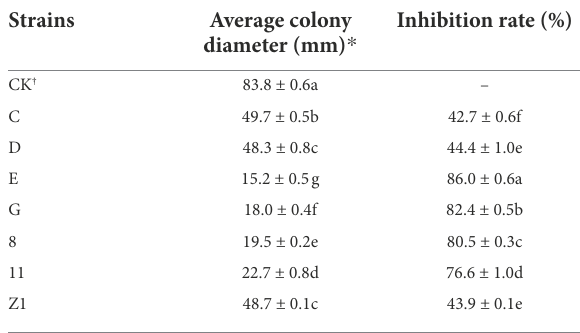
TABLE 1 In vitro antagonistic activity of bacterial strains isolated from soil against Fusarium